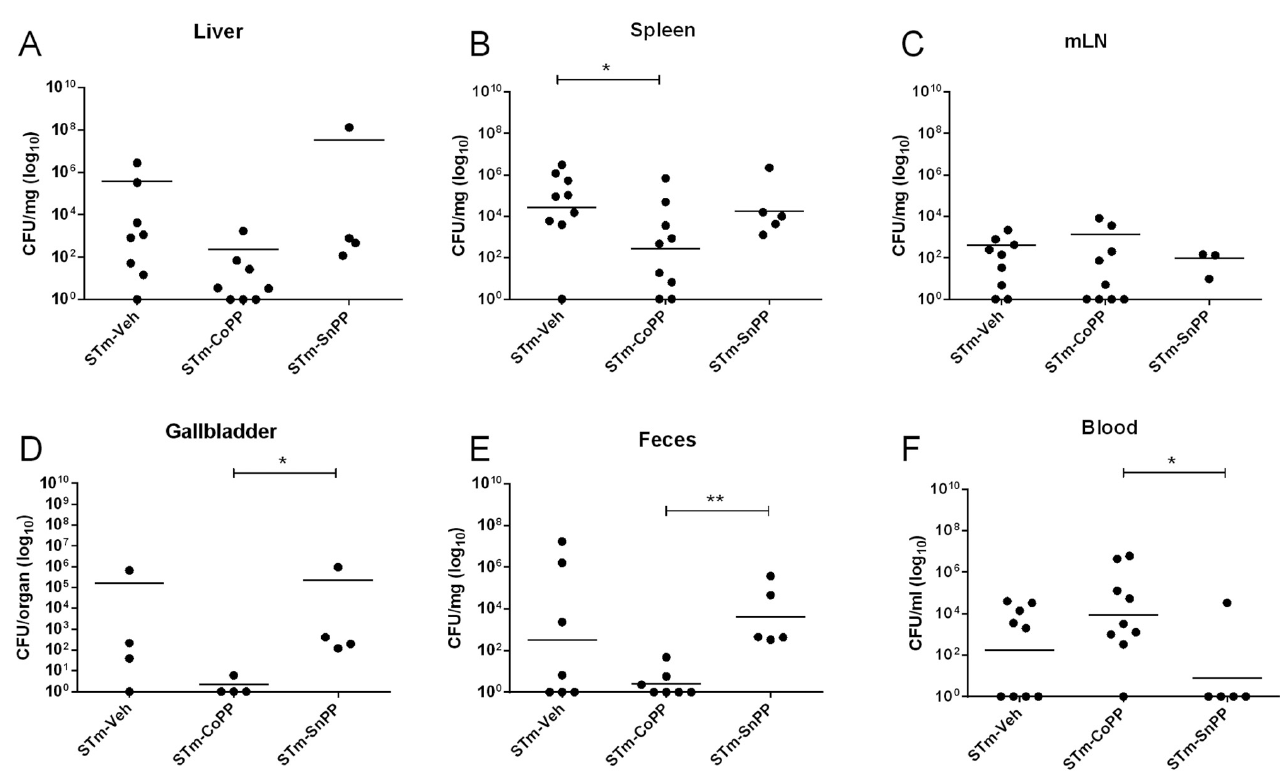
Figure 2. Hmox1 induction with CoPP treatment reduces bacterial loads in an acute S. Typhimurium infection model in mice. Female C57BL/6 mice were treated with CoPP, SnPP, or vehicle 24 h before intragastric infection with 1 × 10 6 CFU of S. Typhimurium. Mice were euthanized on day 5 post-infection and bacterial loads in ( A ) liver, ( B ) spleen, ( C ) mesenteric lymph nodes, ( D ) gallbladder, ( E ) feces and ( F ) blood were measured. Geometric means are shown (STm-Veh n = 11; STm-CoPP n = 10; STm-SnPP n = 8; 3 independent experiments). The Student’s t -test was used to evaluate differences, and results with statistically significant differences are shown (*: p < 0.05; **: p = 0.005).